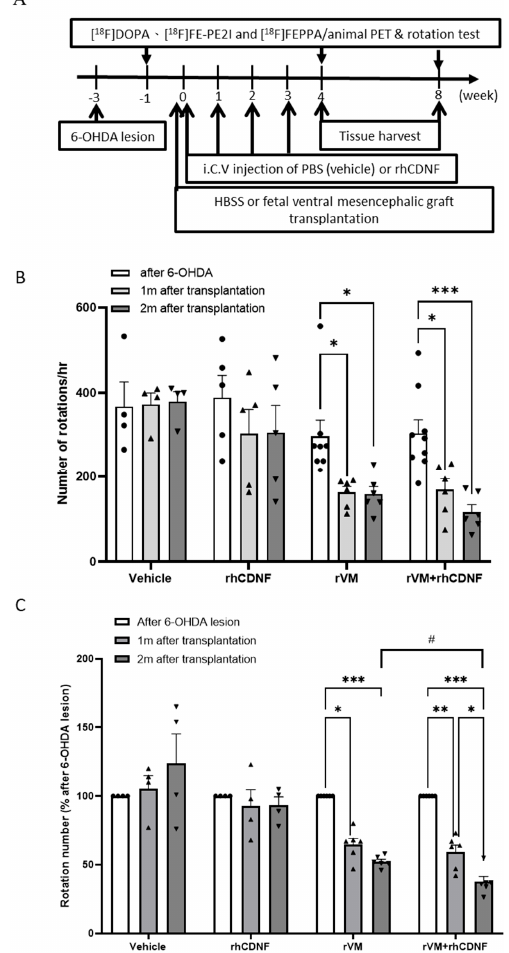
Figure 1. ( A ) Experimental flowchart. [ 18 F] DOPA, [ 18 F] FE − PE2I, and [ 18 F] FEPPA scans were per- formed at four time points (one before and three after a unilateral 6 − hydroxydopamine (6 − OHDA) lesion was made to medial forebrain bundle of the animals. Behavior test refers to the apomorphine- induced rotation test. Transplantation was performed three weeks after the 6 − OHDA lesion was made. RhCDNF or PBS (vehicle) was administered via intracerebroventricular route at four time points. At 4 and 8 weeks after transplantation, the rats were sacrificed for immunohistochemistry (IHC) studies. ( B ) The apomorphine − induced rotation behavior test was used to evaluate dopamin- ergic (DA) function of hemiparkinsonian rats that received PBS (vehicle), rhCDNF alone, rVM, or rVM + rhCDNF. The test was performed before and after transplantation. ( C ) Functional recovery of the PD rats with rVM grafting at 4 and 8 weeks after transplantation, as revealed by proportion of apomorphine-induced rotation number after 6 − OHDA lesioning to after transplantation. RhCDNF treatment further improved functional recovery of PD rats at 8 weeks after transplantation, compared to only rVM grafting. * p < 0.05, ** p < 0.01, *** p < 0.001 by Tukey’s multiple comparisons test, following two-way ANOVA. # p < 0.05 indicates comparison with the rVM + rhCDNF group with two-way ANOVA and Tukey’s post hoc test. The data represent mean ±